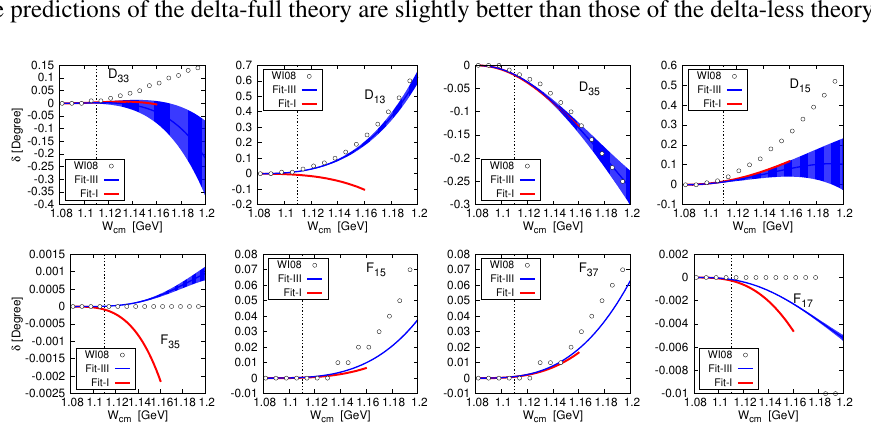
Figure 2. Phase shifts of the D and F PWs from the delta-less and delta-full BChPT corresponding to Fit-I (red) and Fit-III (blue), respectively. The circles correspond to phase shifts by the GWU